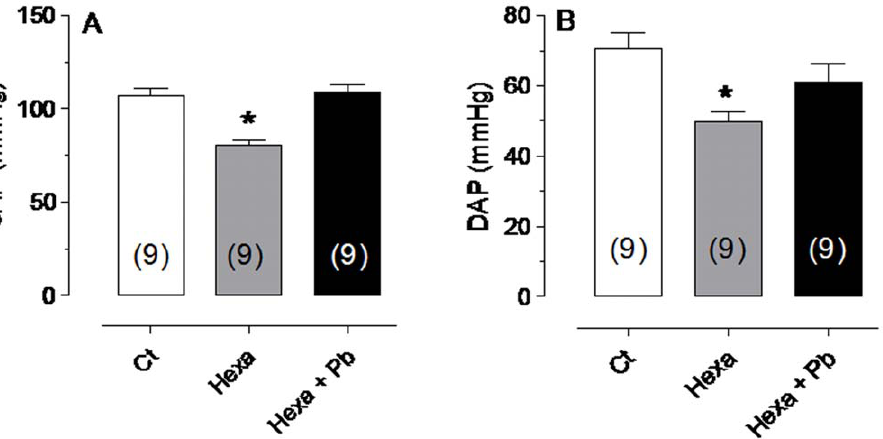
Figure 3. Changes in arterial pressure. Changes in systolic arterial pressure (SAP) and diastolic arterial pressure (DAP) before (Ct) and after Hexamethonium (Hexa) administration and following lead exposure (Hexa + Pb). *p , 0.05 compared with untreated controls. The number of animals used is indicated in parentheses.